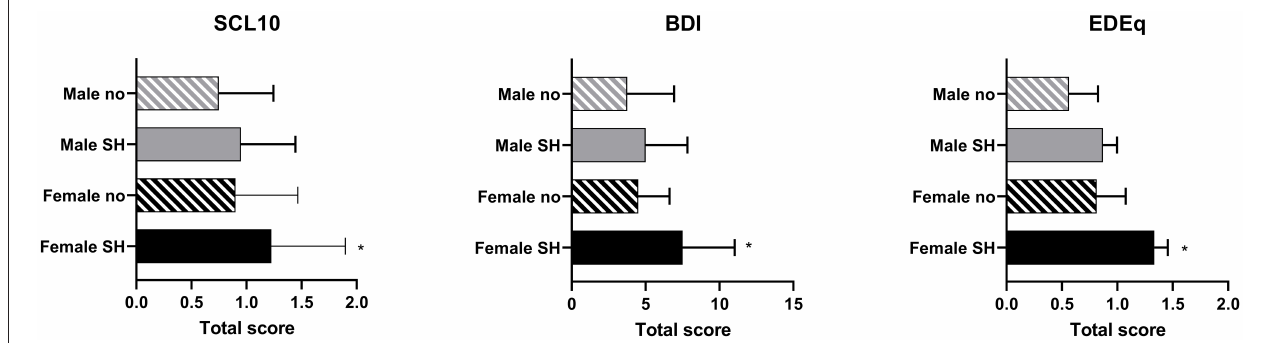
FIGURE 2 | Median (IR) sex-specific scores in BDI, SCL-10, and EDE-q according to whether or not having been exposed to sexual harassment. SCL-10, symptom checklist; BDI, Beck Depression Inventory; EDEq, Eating Disorder Examination Questionnaire; Male no, males not exposed to sexual harassment; Male SH, males exposed to sexual harassment; Female no, females not exposed to sexual harassment; Female SH, females exposed to sexual harassment. *Significant difference between the two groups of females, p < 0.01.